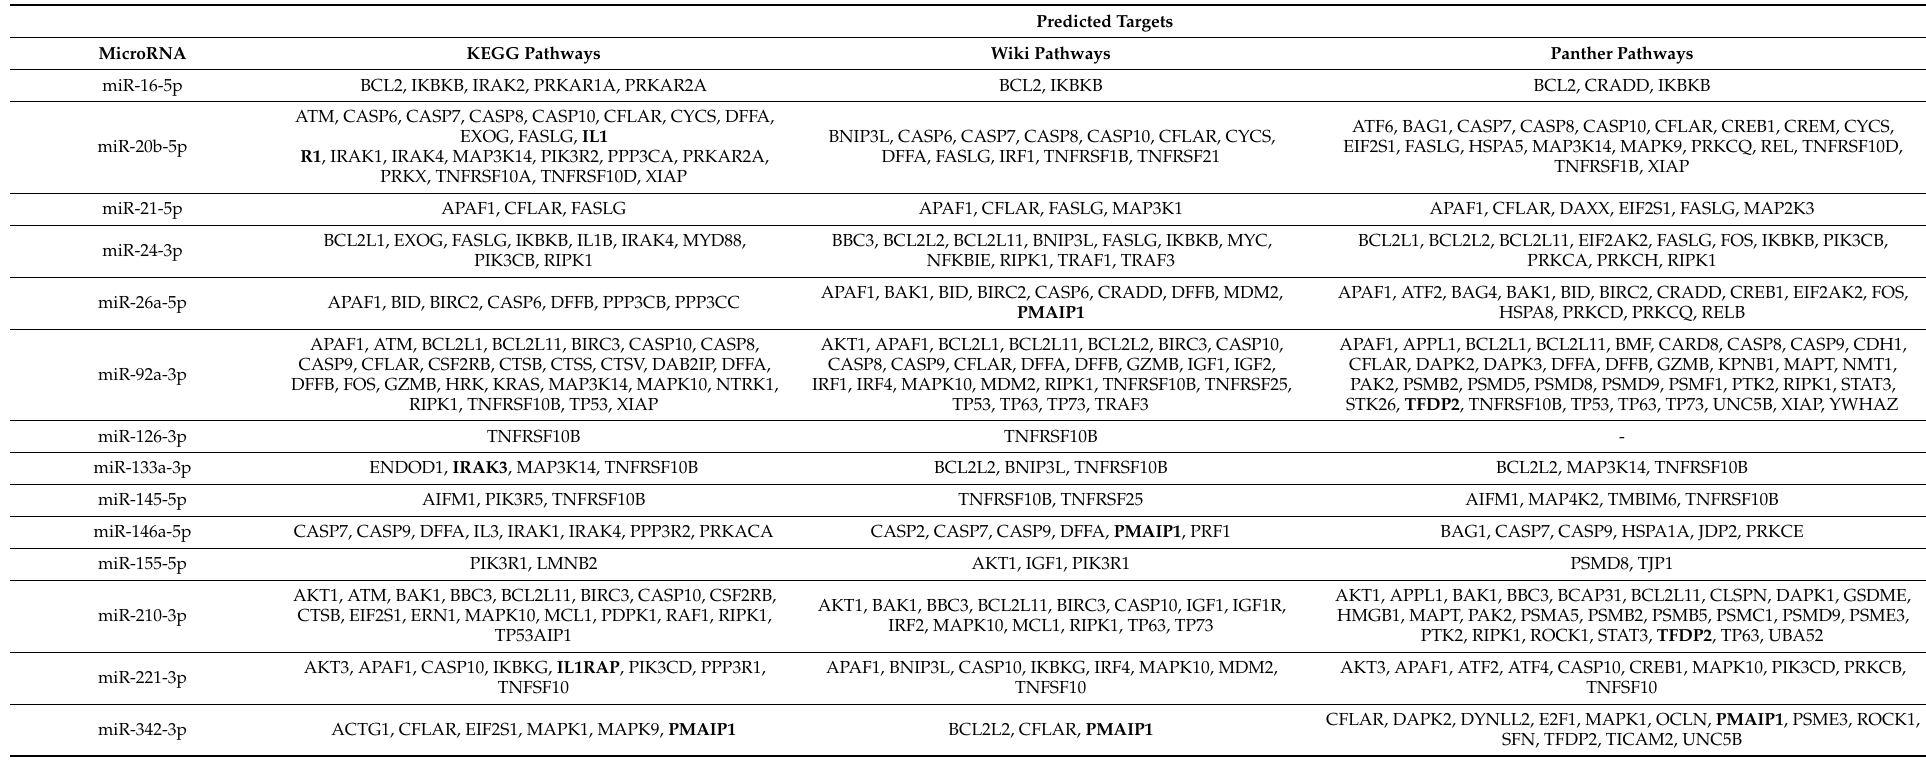
Table 2. A List of Predicted Targets of MicroRNAs Dysregulated in the Whole Peripheral Blood of Pregnancies at Risk of Preterm Delivery in relation to the Apoptosis Pathway, using the miRWalk2.0 Database (Data Available in the KEGG, WIKI, and Panther Pathways). Predicted